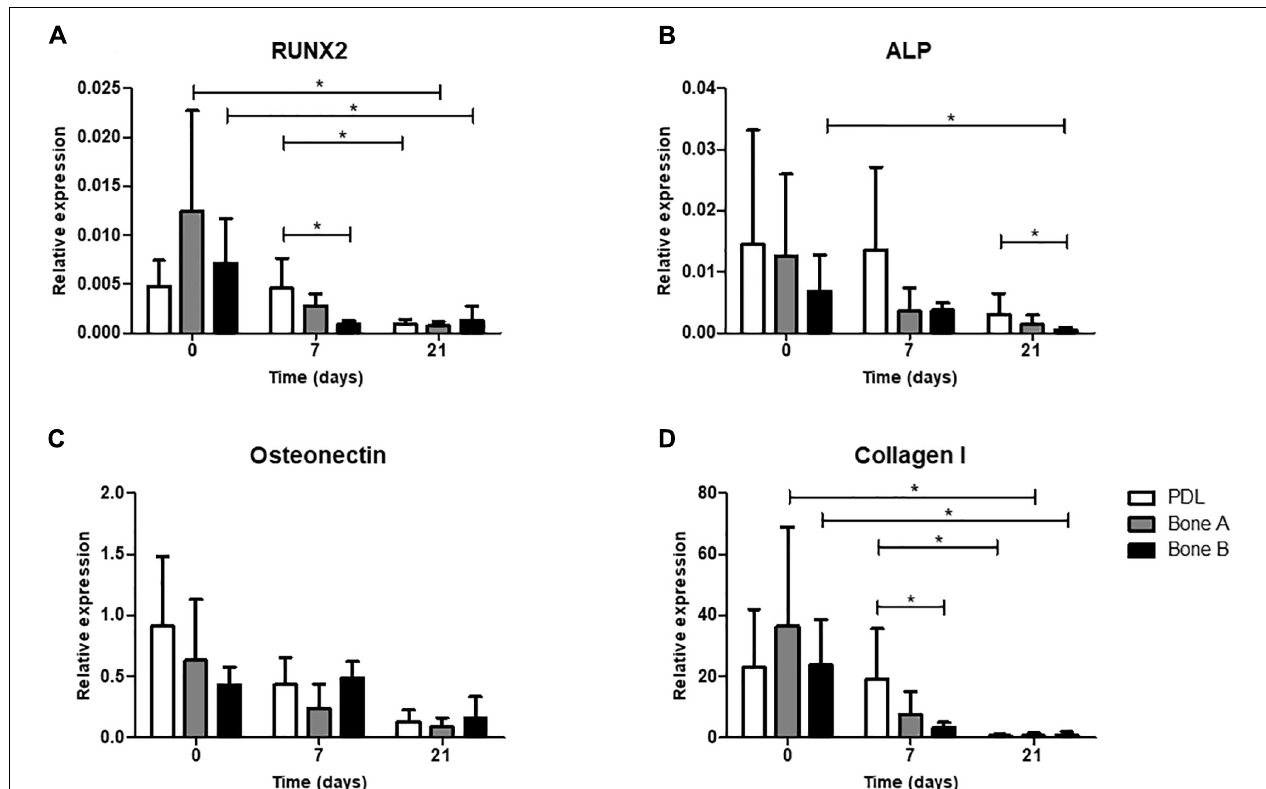
FIGURE 7 | Osteogenic gene expression at day 0 (without osteogenic medium) and after 7 and 21 days of culturing under osteogenic condition. (A) Gene expression of early marker RUNX2, (B) Alkaline phosphatase, (C) bone matrix protein Osteonectin and (D) bone matrix marker Collagen I was assessed for PDL, bone A and bone B. Expression is depicted relative to housekeeping gene Beta-2-microglobulin. Note the difference in scale of the y-axes. Means ± SD are shown ( n = 5). * p < 0.05 (Friedman test with Dunn’s multiple comparison post hoc